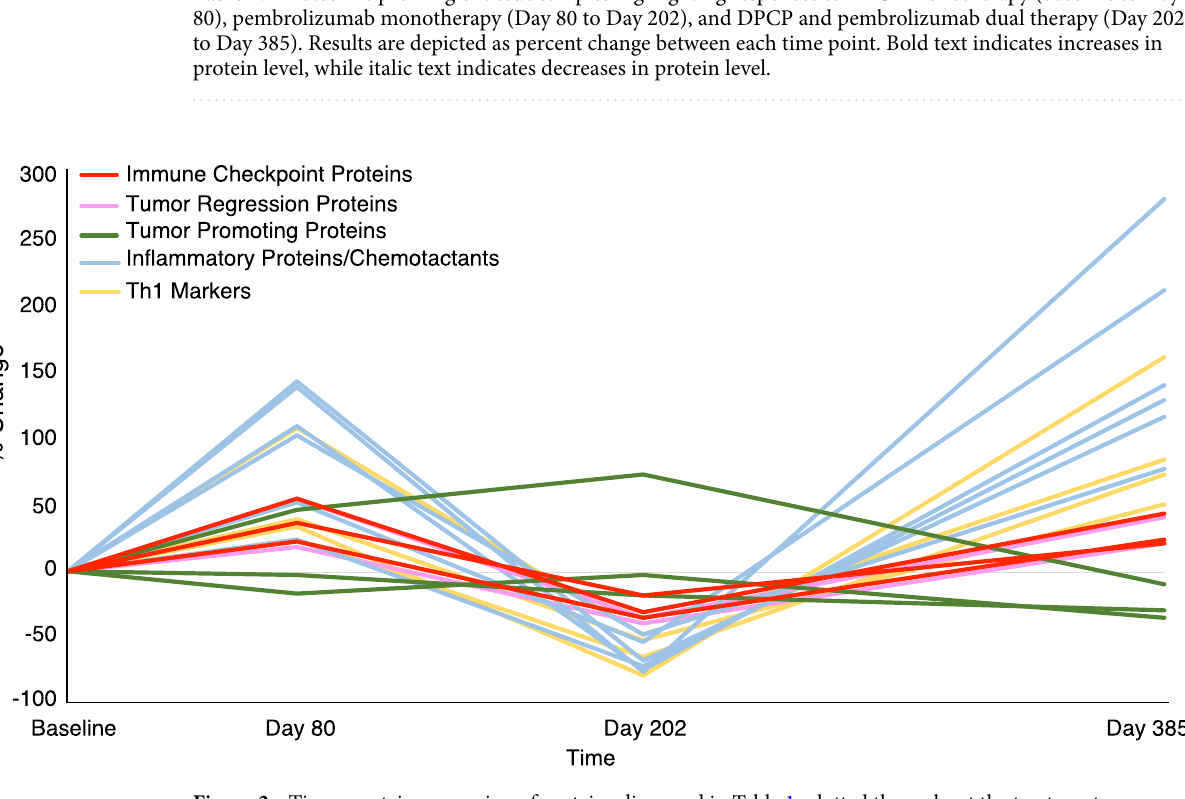
Figure 3. Tissue protein expression of proteins discussed in Table 1, plotted throughout the treatment course. Proteins are color coded by pathway and function. Five groups are represented including immune checkpoint proteins (PD-1, PD-L1, and LAG-3), tumor regression proteins (TNFSF14, GZMA), tumor promoting proteins (CCL17, CD70, LAMP3), inflammatory proteins/chemotactants (CXCL1, IL-6, IL-8, MCP-1, MCP-2, MMP12), and Th1 markers (CXCL9, CXCL10, CXCL11,